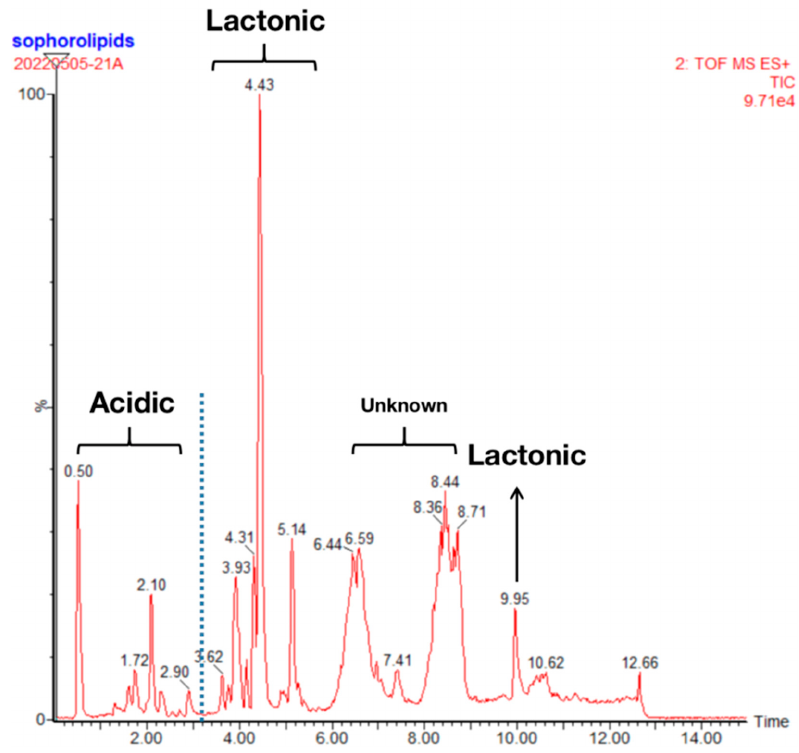
Figure 1. HPLC chromatogram of SL. Table 1. Different Structural Modifications of SL.